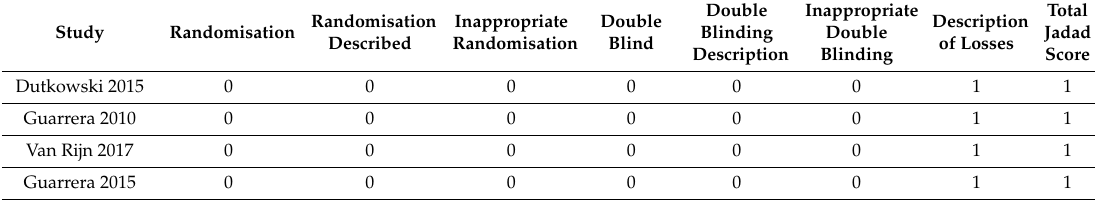
Table 6. Risk of bias assessment of studies comparing HMP and SCS in liver.